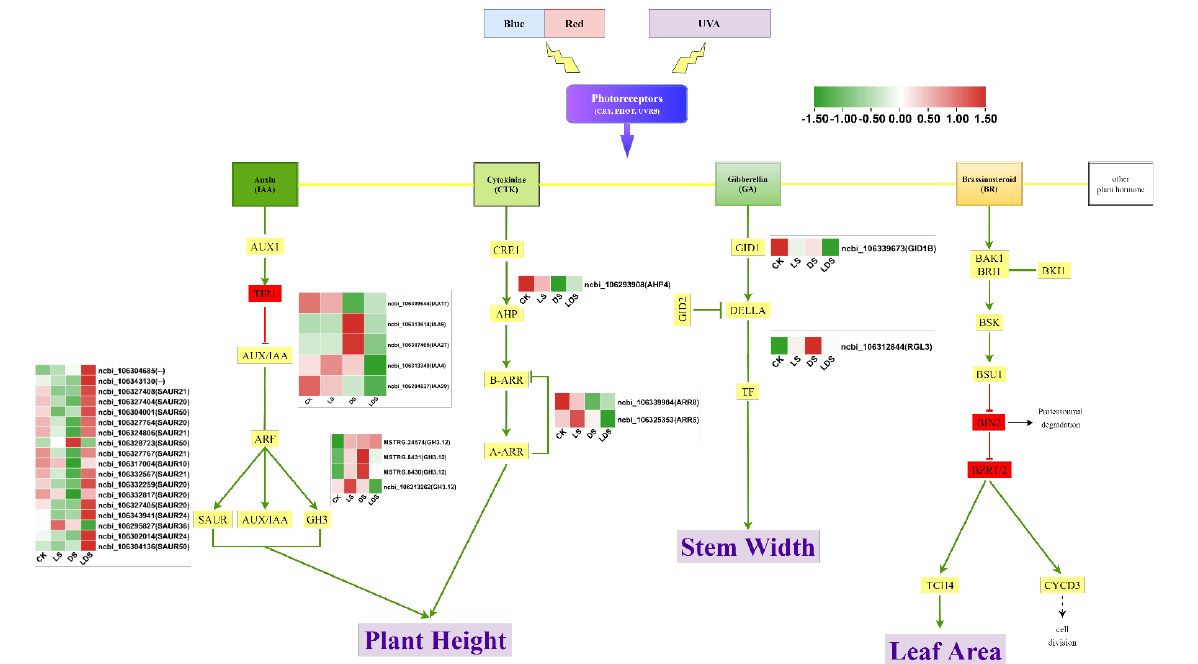
Figure 4. Expression of DEGs on plant hormone signal transduction pathway. Made by diagrams.net.